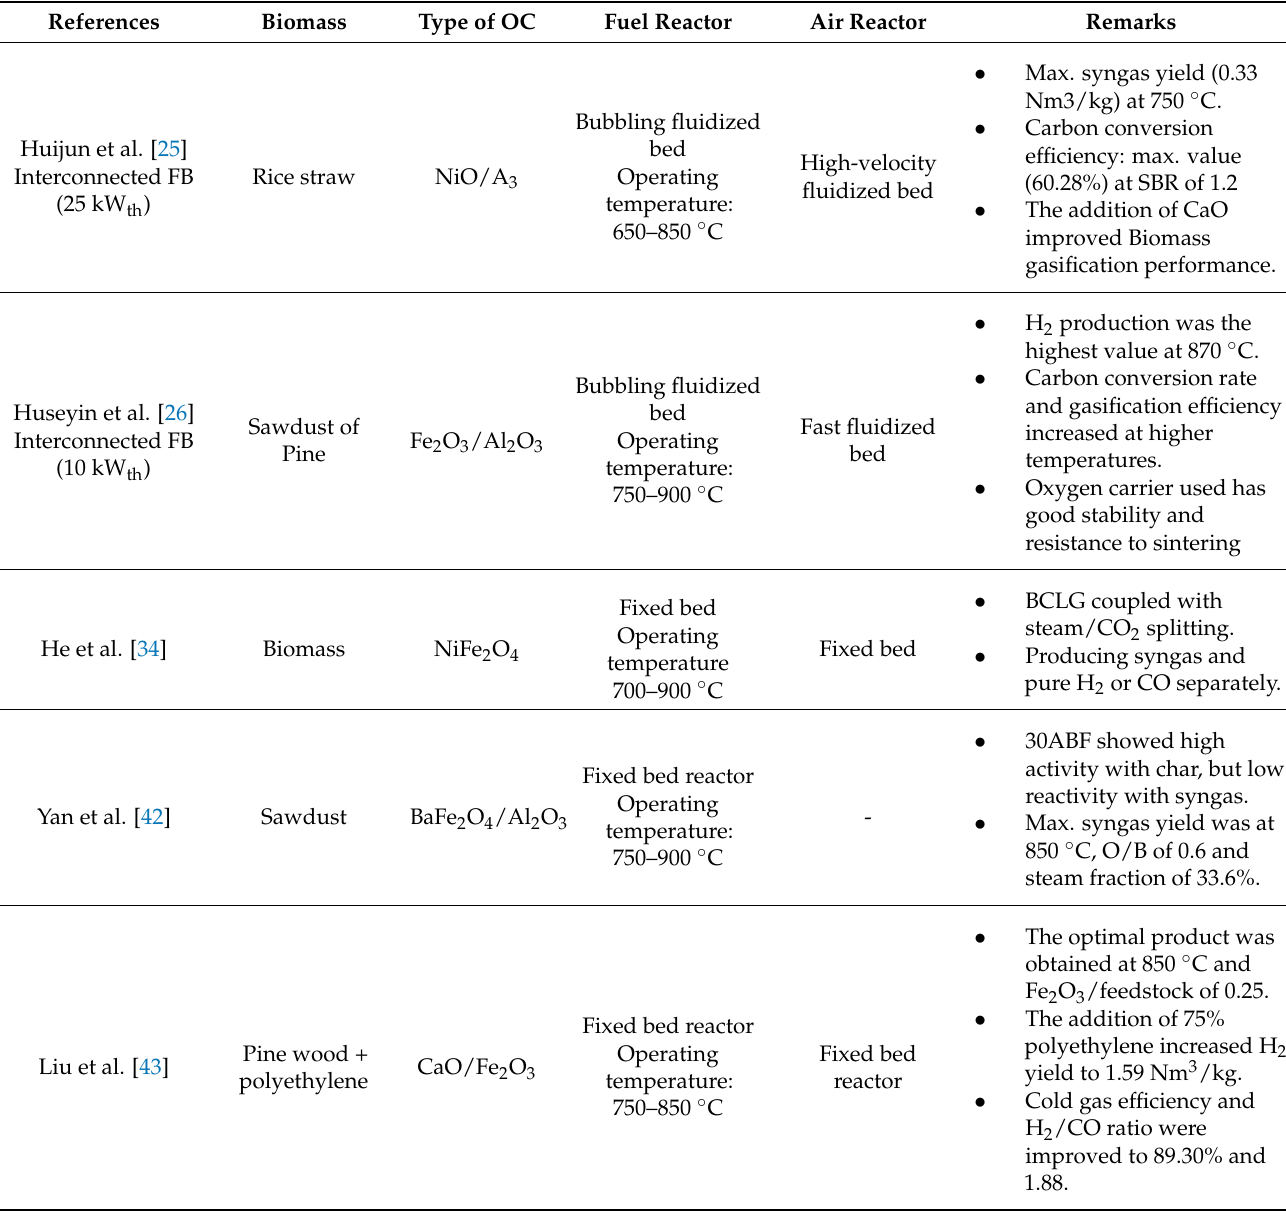
Table 6. Summary of the key information of recent experimental studies in